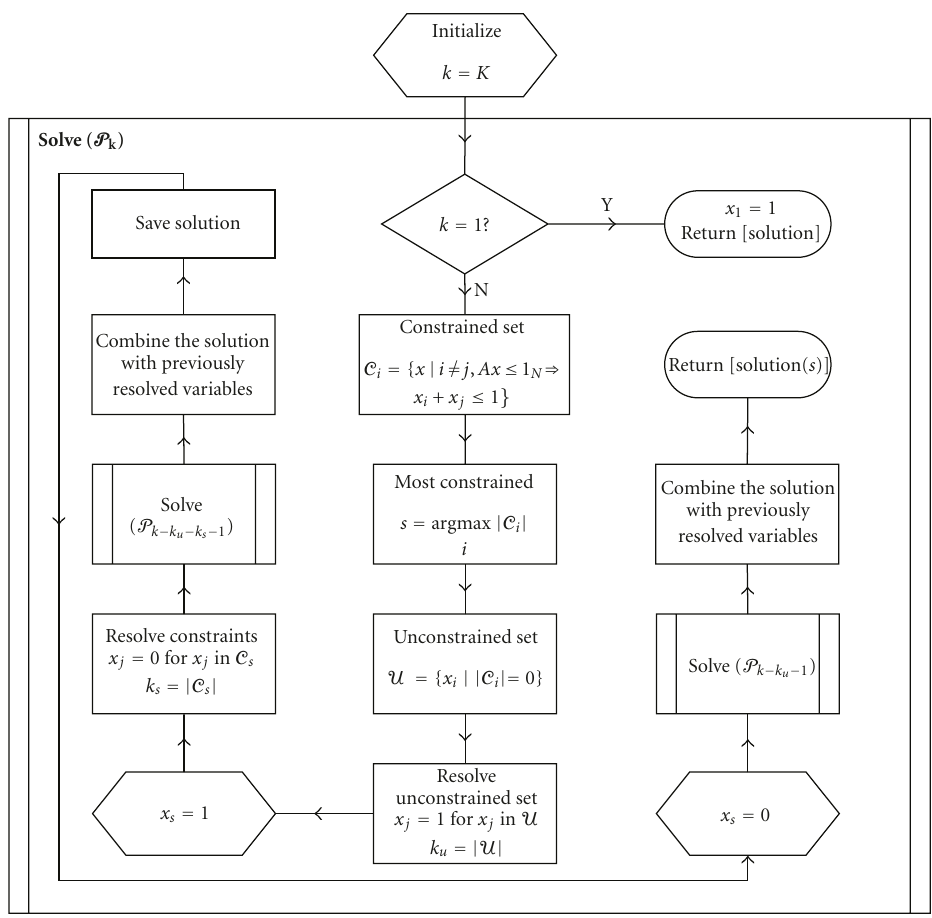
Figure 1: A schematic of Algorithm 1 with greedy pruning for finding the optimal network coding solution of (4). Note that the algorithm and P k − k within is recursive as it calls P k − k u − k s − 1 u − 1